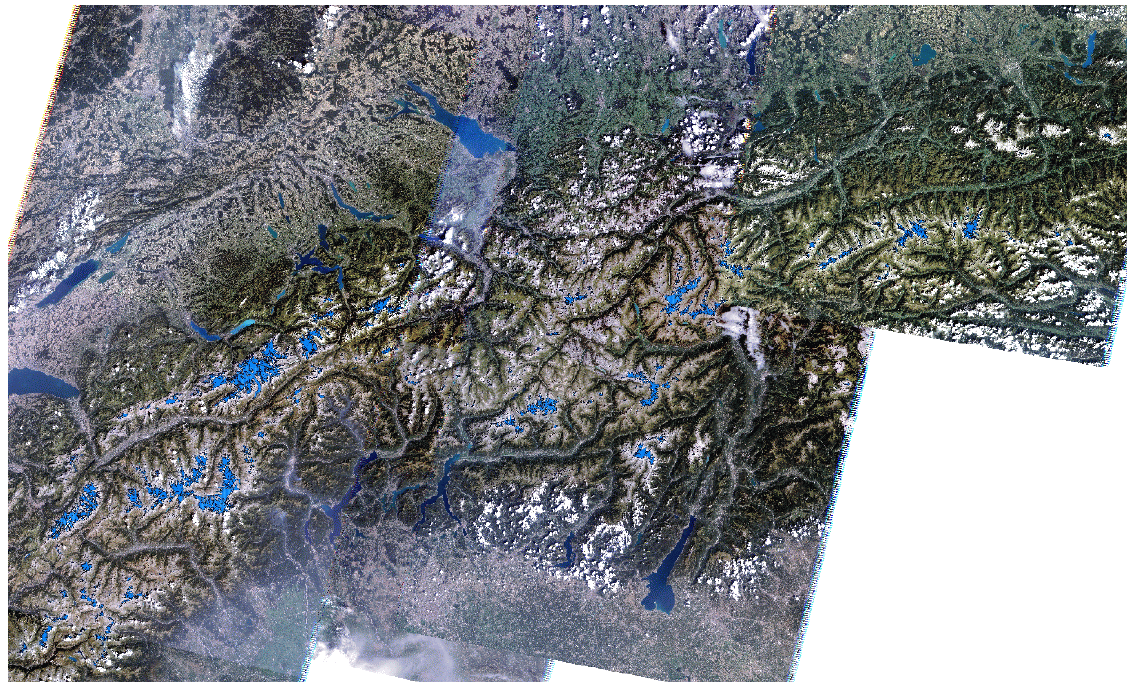
Figure 5. The new glacier inventory for the entire Alps as obtained from ten Landsat TM scenes acquired in 2003. The background shows a mosaic of the scenes used in the inventory in natural colors and the light blue areas with black outlines depict the mapped glaciers. Image source: